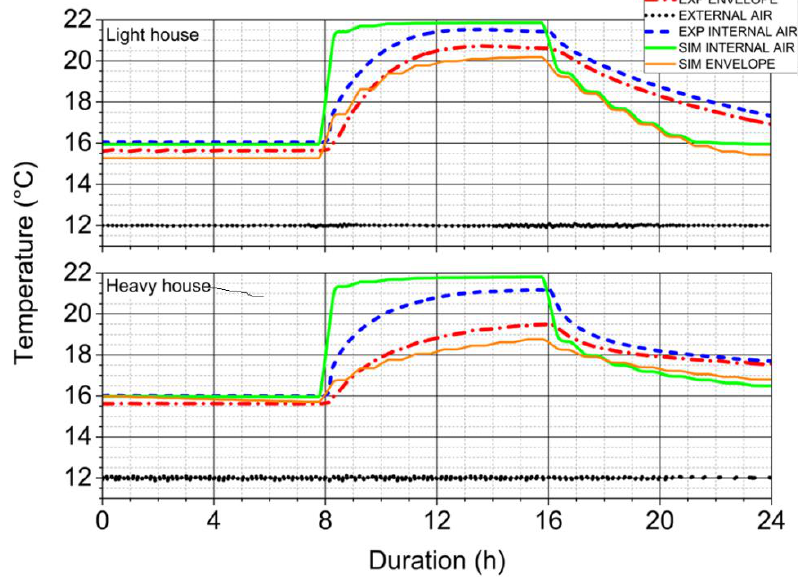
Figure 17. Localization of the heaters in the test chamber.